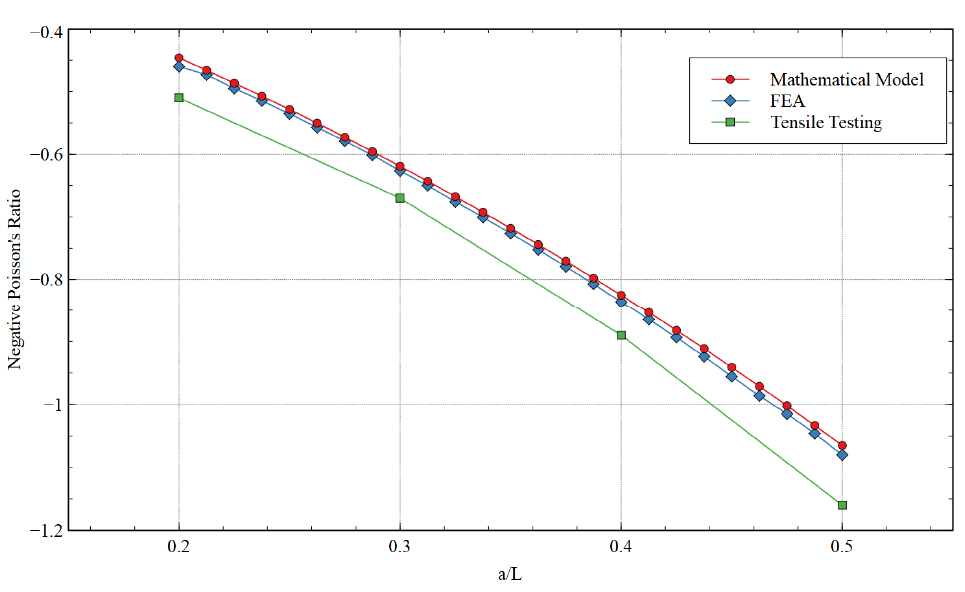
Figure 11. Poisson’s ratio obtained via a mathematical model, FEA, and tensile testing for loading in